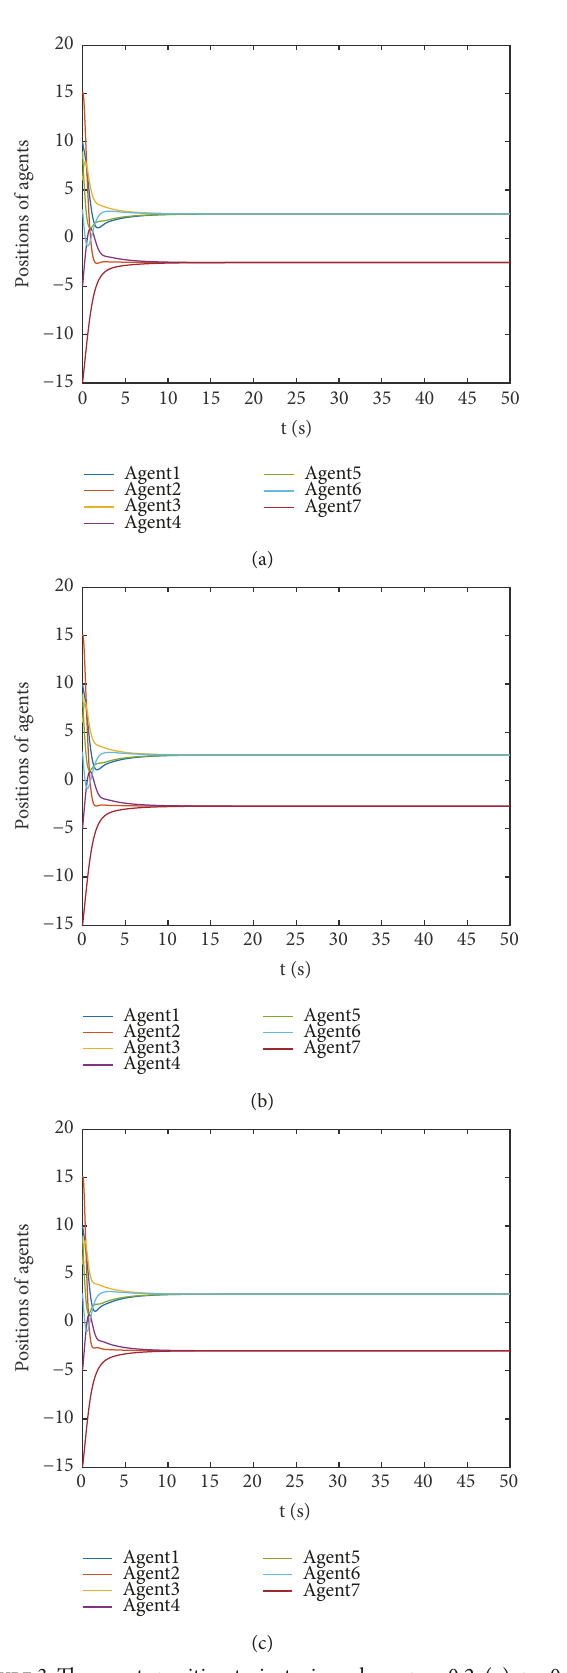
Figure 3: The agents position trajectories, where 𝜏 𝑖𝑗 = 0.2 . (a) 𝜏 = 0 , (b) 𝜏 = 0.03 , and (c) 𝜏 = 0.08 .